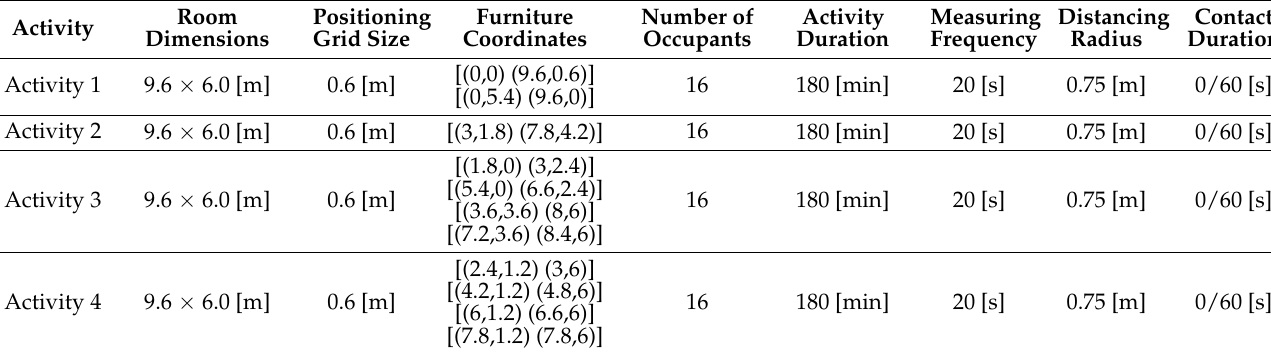
Table 1. Overview of variables entered by researchers for four